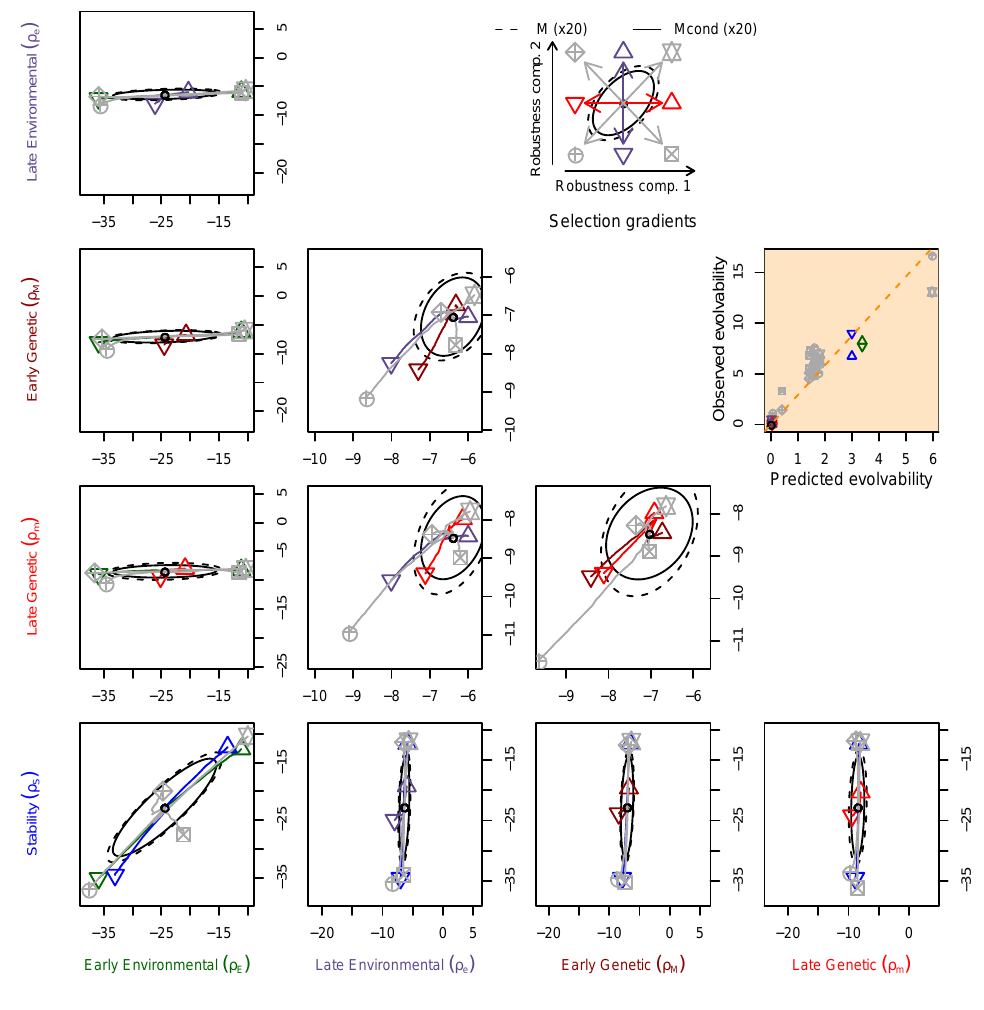
Figure 4 – Trajectories of the bivariate response to selection over 5000 generations (av- erage over 100 simulation replicates) for all combinations of robustness indicators. Each panel displays the selection response in eight directions, as illustrated in the legend (four univariate — colored arrows — and four bivariate — gray arrows — gradients of selection, same color code as in Figure 3). Mutational and conditional mutational matrices, esti- mated from the initial genotypes, are illustrated as ellipses in each panel (95% ellipses assuming a multivariate Gaussian mutational distribution). For conditional M c matrices, the constraining traits were the three gene which expression was under stabilizing selec- tion. X and Y axes were adjusted so that their scale matches for each trait comparison (correlational ellipses were not distorted). The colored inset illustrates the proportional- ity between the predicted mutational evolvability (calculated from M c ) and the observed evolvability in the direction of selection after 1000 generations (same color/symbol code as in the rest of the figure, hyphenated line: linear regression with no